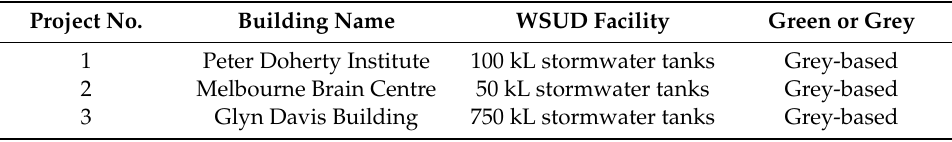
Table 1. The existing water sensitive urban design (WSUD) projects in the University of Melbourne. Project No.